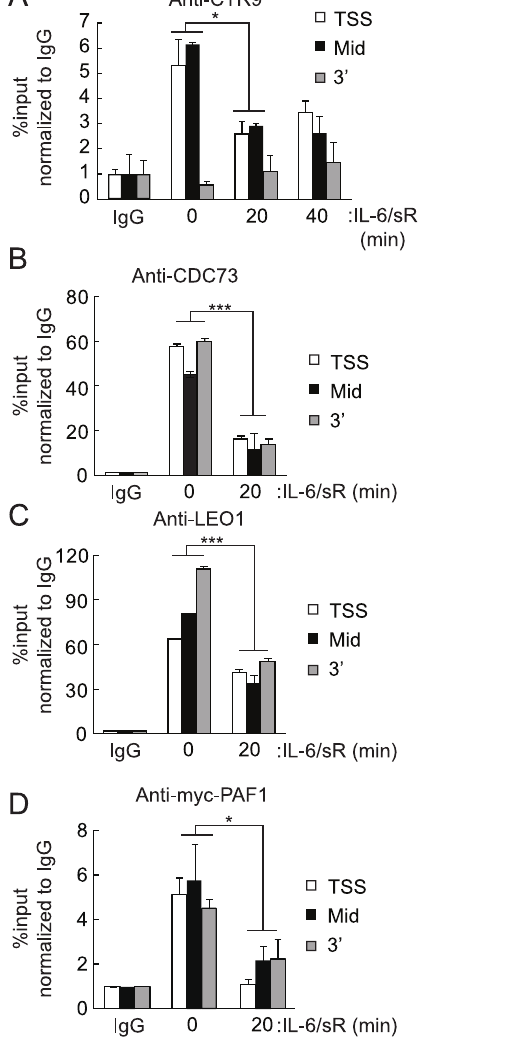
Figure 4. PAFc dissociates from the c-Fos locus after IL-6 stimulation. HepG2 cells were treated with IL-6 plus IL-6sR (20 ng/ml each) for the indicated length of time. Soluble chromatins were immunoprecipitated with anti-CTR9 antibodies, and the bound DNAs were analyzed by quantitative PCR using primers specific to c-Fos ( A ). ( B,C ) CDC73 and LEO1 associations with c-Fos locus were analyzed after IL-6 plus IL-6sR (20 ng/ml each) stimulation. ( D ) Cells were transfected with Myc-PAF1 and 48 hours later, cells were treated with IL-6 plus IL-6sR (20 ng/ml each) for 20 minutes. ChIP assay was performed with anti-Myc antibody and bound DNAs were analyzed by quantitative PCR using primers specific to c-Fos. *p , 0.05, ***p , 0.001 by Student’s t test. Error bars represents SD (n=3).